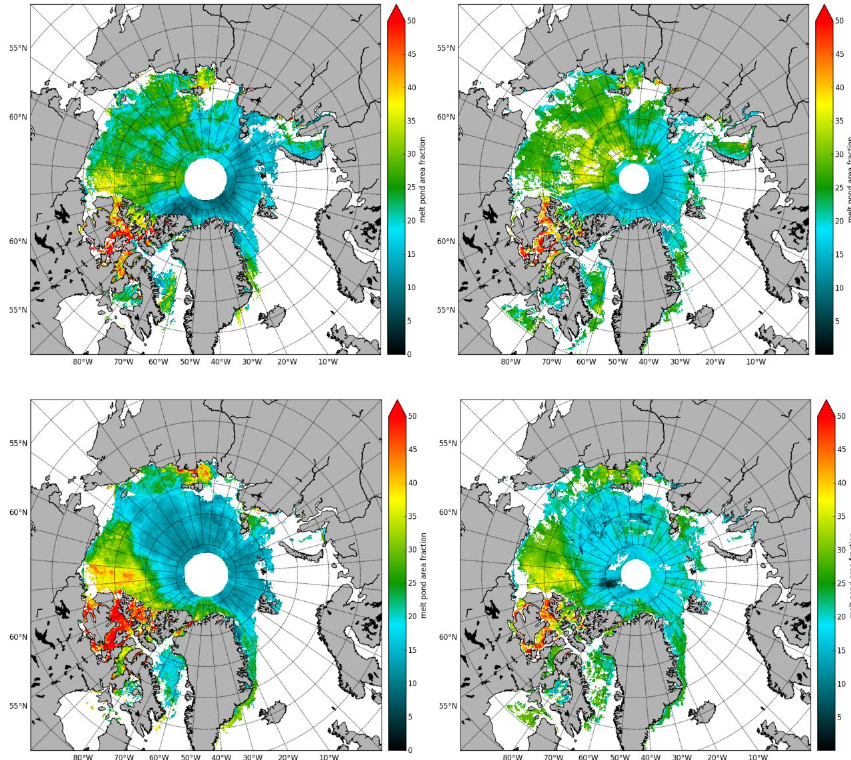
Figure 6. Comparison of the MPD MPF (8-day average, left column panels) to the MPF from (Rösel and Kaleschke, 2012) (8-day composite, right column) for 18 June 2007 (top row panels) and 18 June 2011 (bottom row